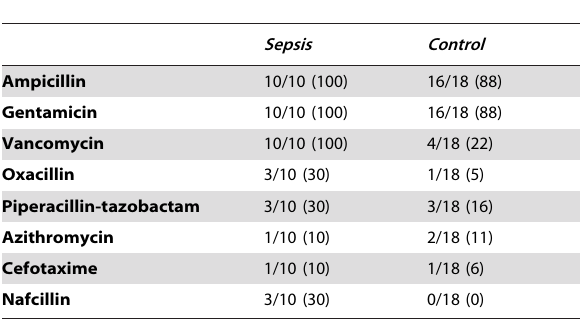
Table 4. Antibiotic exposure. – no./total no.